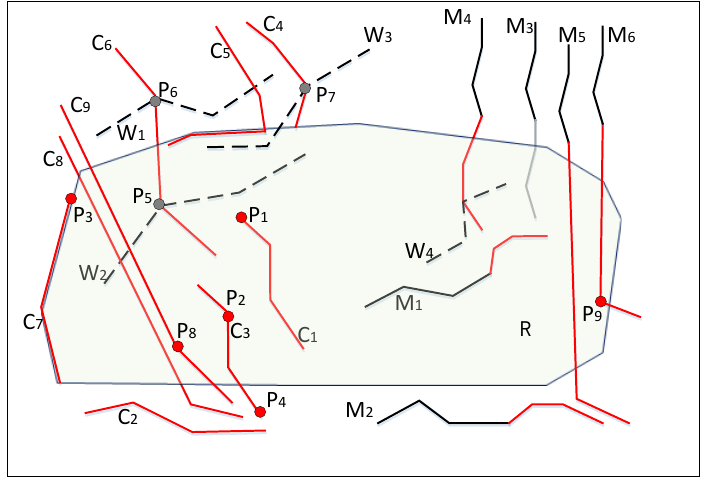
Figure 4. The relationships between changed way and the research region considering the evolution of the